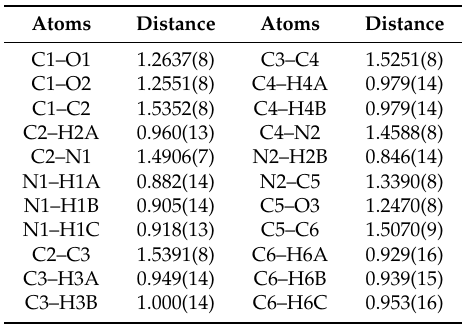
( b ) Figure 4. Crystal structure of γ -NADA at 100 K, view along [010] ( a ) and [–100] ( b ). Atoms are shown at the 80% probability level with carbon as black, hydrogen is white, oxygen as red, and nitrogen as blue ellipsoids. Strong H bonds are drawn as dashed lines.